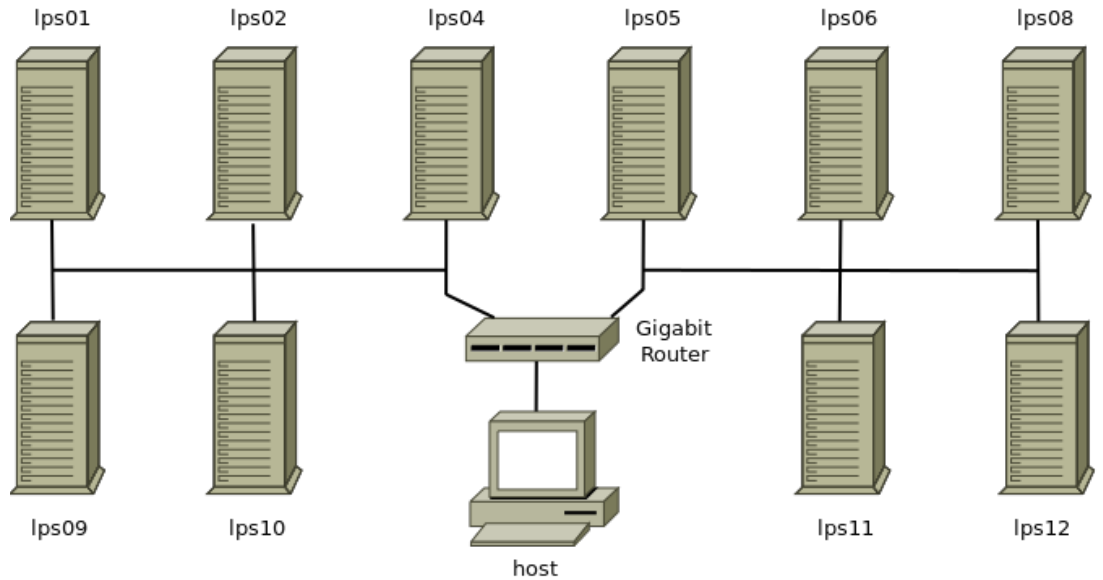
Figure 3. Beowulf cluster used in the experiments. Lines between devices may represent multiple Ethernet cables for diagram cleanliness purposes. Cluster nodes are prefixed with “lps”. Detailed cluster configuration is informed in the Appendix